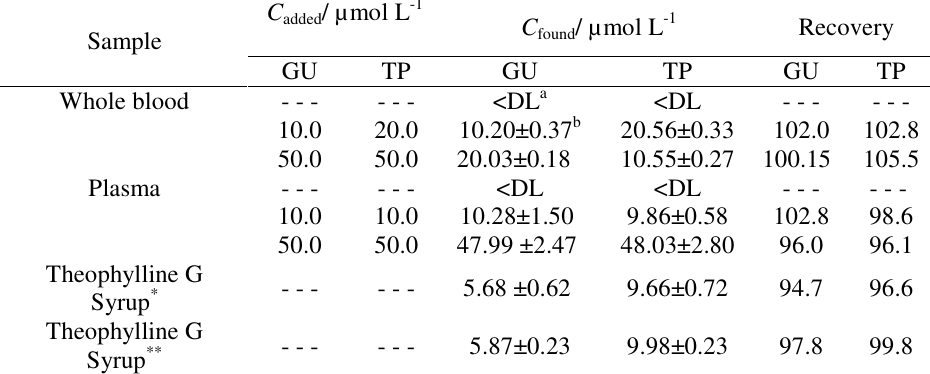
Table 4. Determination of guaifenesin and theophylline in some pharmaceutical formulations and biological